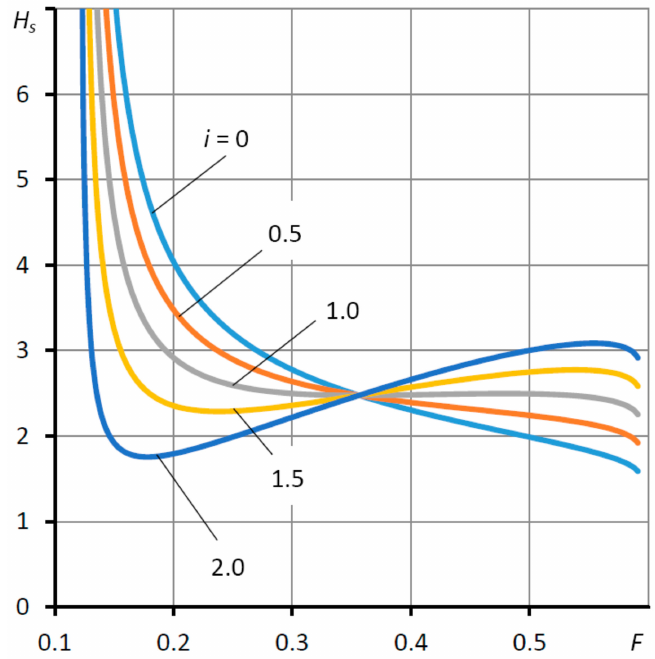
Figure 2. Load characteristics H s ( F ) of the thrust bearing at different values of the elasticity coefficient K e = i K e 0